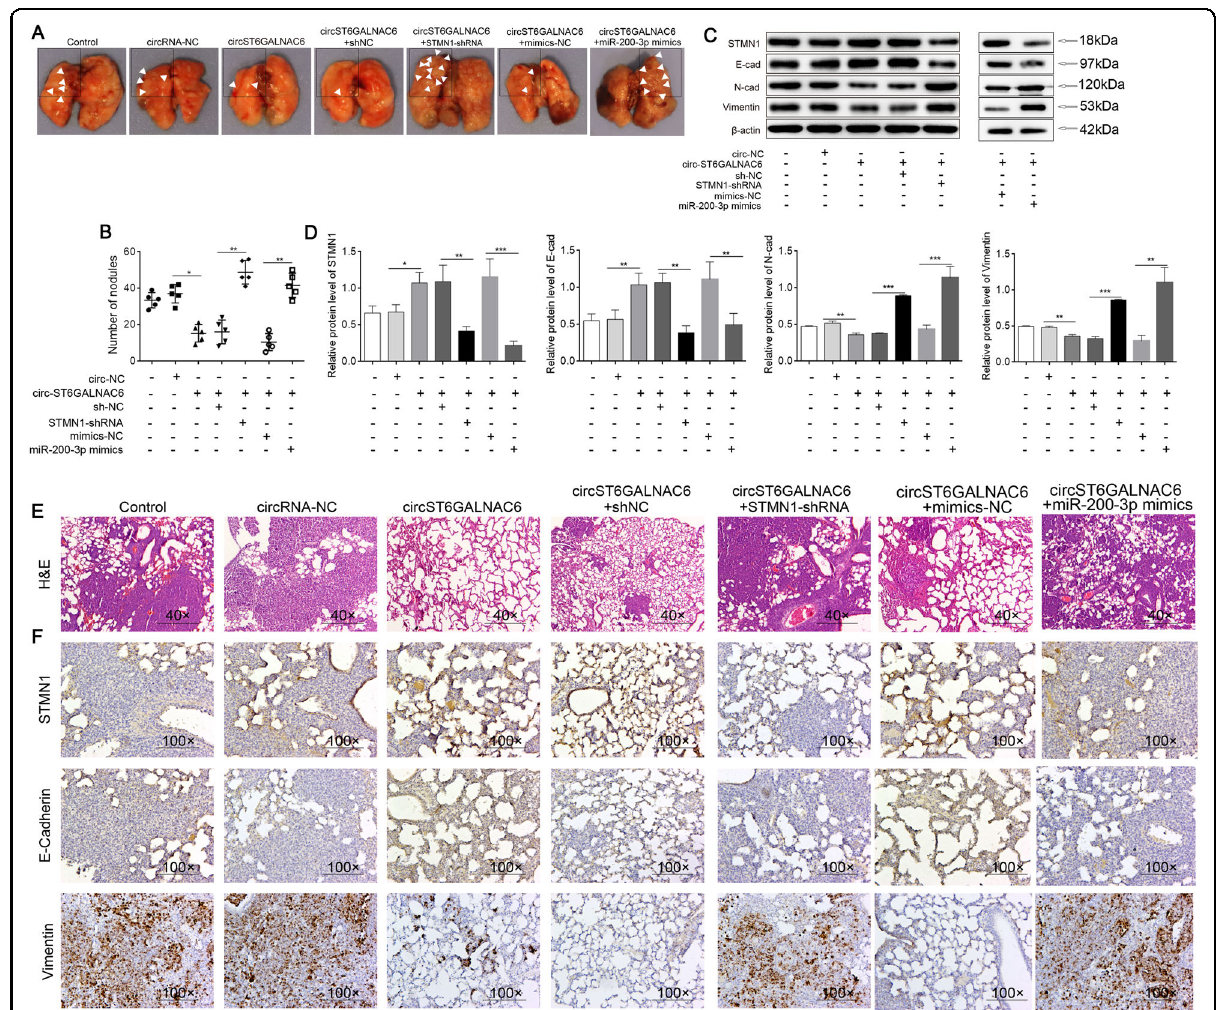
Fig. 7 circST6GALNAC6 inhibited bladder cancer growth in vivo via miR-200a-3p/STMN1. A Representative images of lung metastatic nodules are shown. B The number of metastatic nodules was quanti fi ed in each group of mice. C , D STMN1 and EMT-related protein expression in tumours from each group of mice were detected by western blotting ( C ) and quanti fi ed ( D ). E H&E staining analysis of lung tissues from each group of mice. F STMN1, E-cadherin and vimentin expression was detected via IHC in each group of mice. *** P < 0.001, ** P < 0.01 and * P <